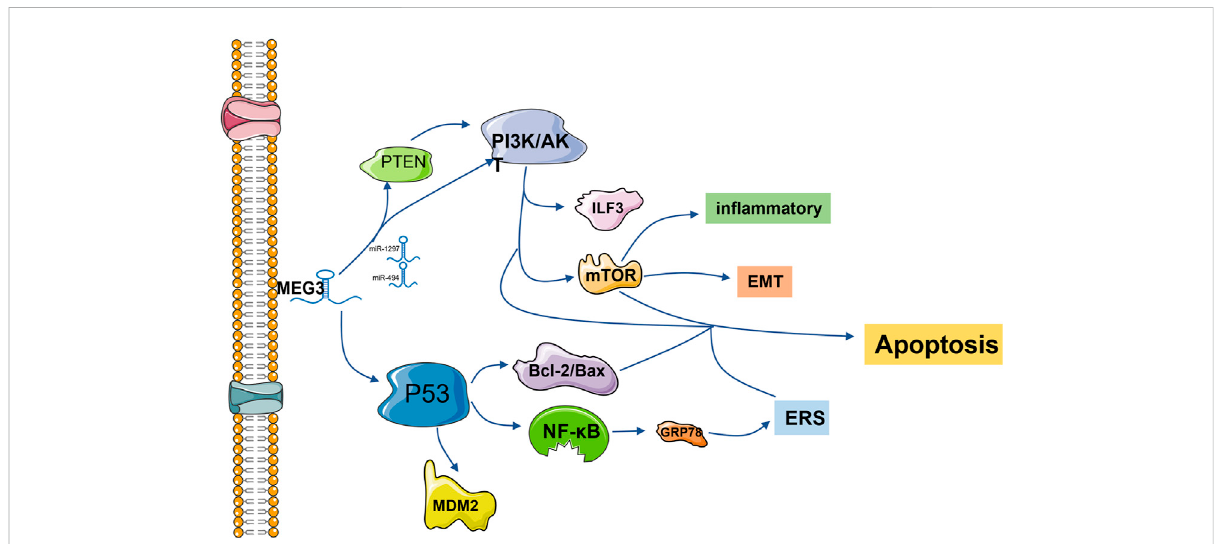
FIGURE 1 lncRNA MEG3 is frequently involved in endoplasmic reticulum stress, apoptosis, in fl ammation and epithelial-mesenchymal transformation via theP53andPI3K/AKTpathways.ThecommondownstreampathwaysareMDM2,NF- κ B,Bcl-2/Bax,mTORandotherproteinpathways.Regulationis also accomplished by competitively binding downstream protein pathways with miRNA.